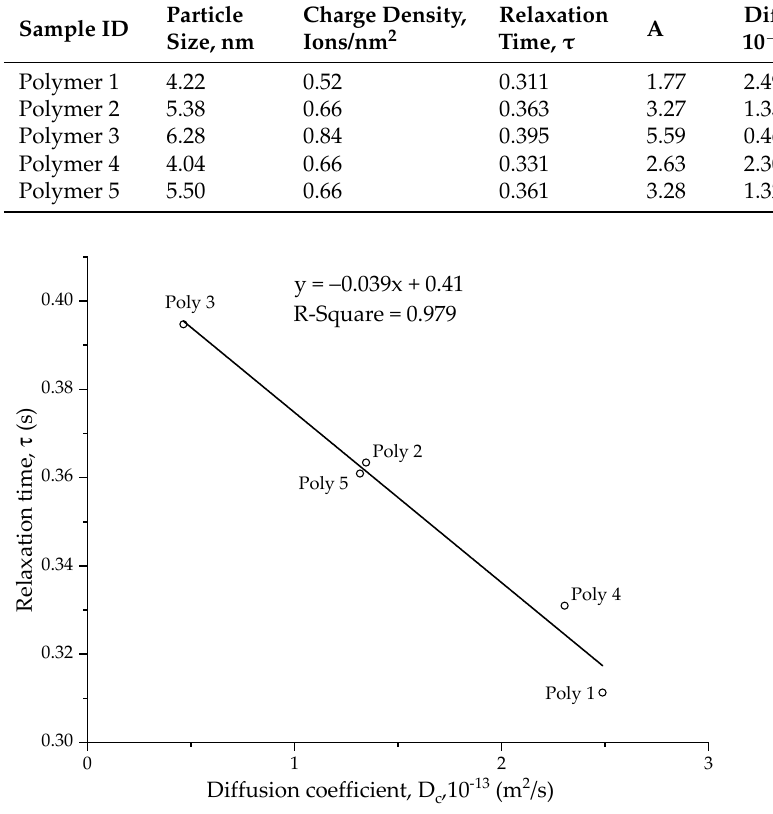
Figure 12. Relaxation time, τ (s), against the diffusion coefficient, D c (m 2 /s), at a 1.03 mol/m 3 concentration of CUP polymers 1–5.